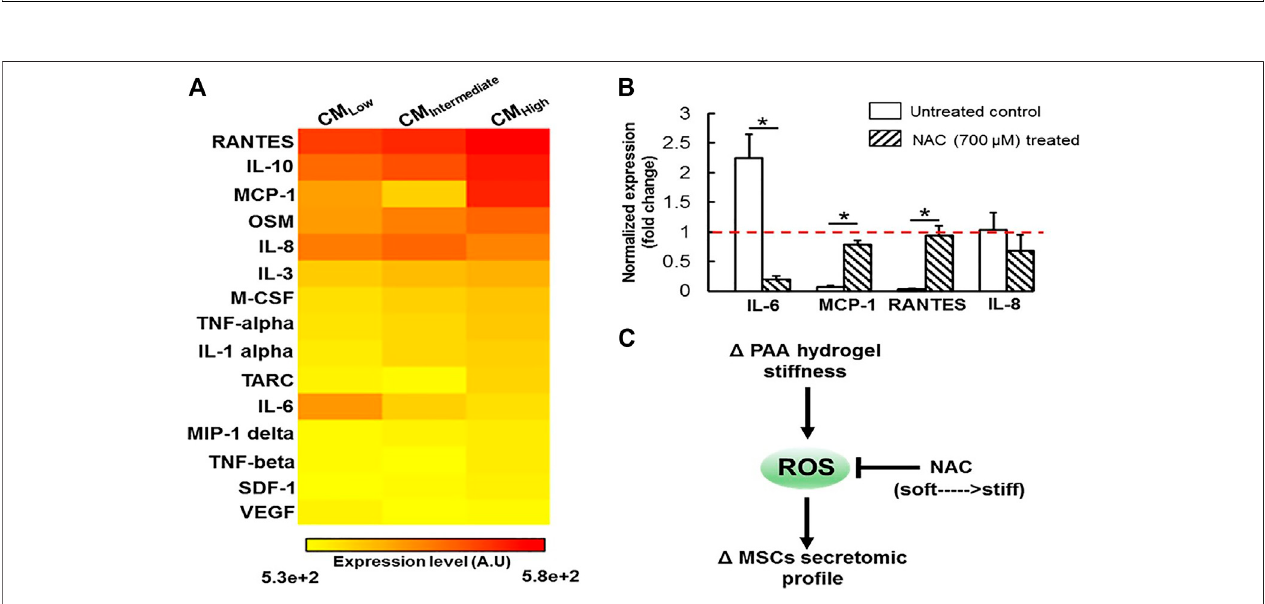
FIGURE 4 | Integrins and cadherin affect the differentiation and proliferation of MSCs by affecting the related protein/YAP translocation. Adapted with permission from (Selig et al., 2020). Related data adapted from (Cosgrove et al., 2016).